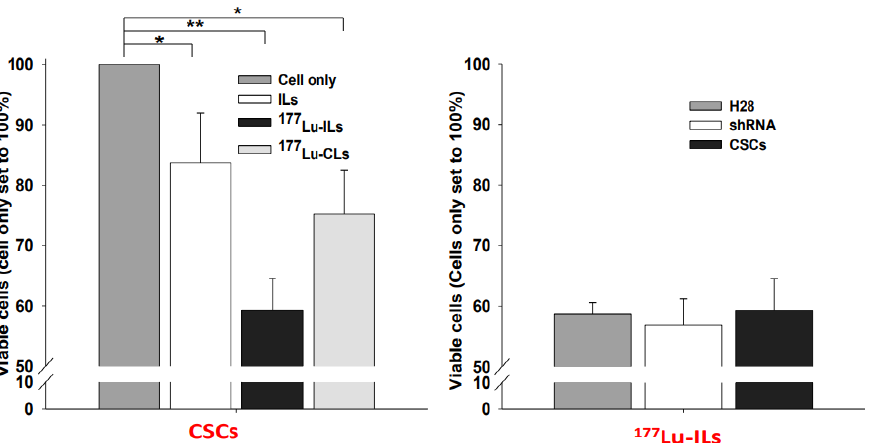
Figure 7. Cytotoxicity in CSCs treated with 177 Lu-ILs or 177 Lu-CLs. MMs were plated and incubated overnight to allow cell attachment. The MMs were treated with 177 Lu-IL or 177 Lu-CL. Control wells were treated with media alone or ILs only. After 1 h incubation, the media were replaced with fresh media, further incubated for 48 h, and cell viability was determined using MTS. Percentage survival was calculated by setting untreated CSCs as 100% (left). MM cell lines treated with 177 Lu-ILs were compared with untreated cells (right). Mean ± SD ( n = 3), p < 0.05 (*), and p < 0.01 (**). Apoptosis of MMs induced by ILs, 177 Lu-CLs, and 177 Lu-ILs was also performed in vitro (Figure 8). As shown in the Figure 8 (left panel), significantly increased apoptosis of CSCs was detected in all treatment groups compared with untreated cells. 177 Lu-ILs ( p < 0.01) induced significant apoptosis of CSCs and H28 cells, but not shRNA cells, presuma- bly due to reduced targets of CD24 and 26 (Figure 8, right panel). 177 Lu-ILs treatment in- duced the most significant apoptosis of CSCs compared to ILs and 177 Lu-CLs, which may be attributed to double effects from immunotherapy from two antibodies and the radia- tion from 177 Lu. Taken together, our results suggest that RIT is a promising therapeutic modality for targeting CSCs due to its enhanced tumor cell killing ability.